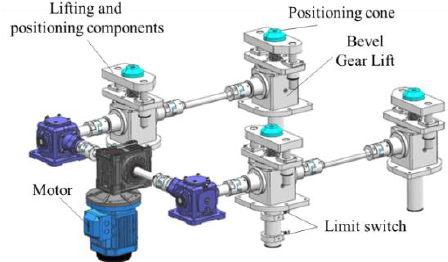
Figure 12. Model of lifting drive assembly. ⚫